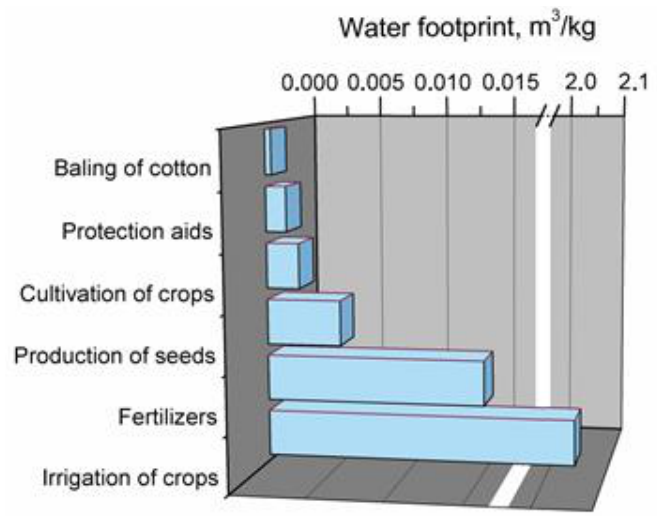
Figure 8. Main components of production system generating water footprint of cotton fibers.